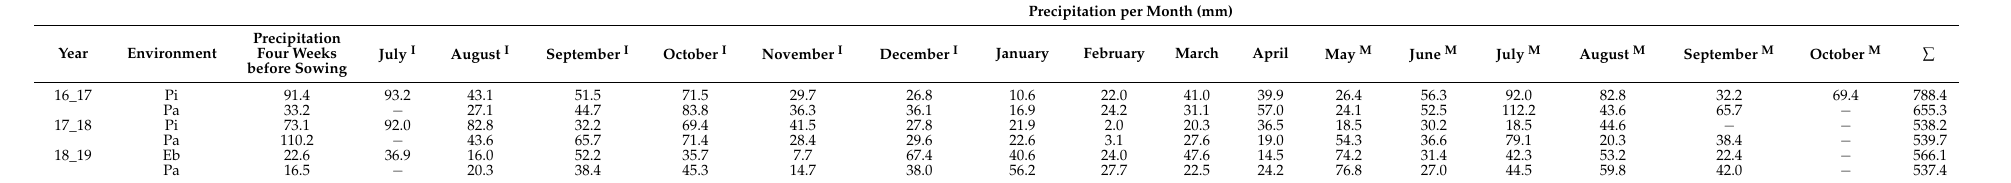
Table 2. Precipitation during growing season over the three experimental